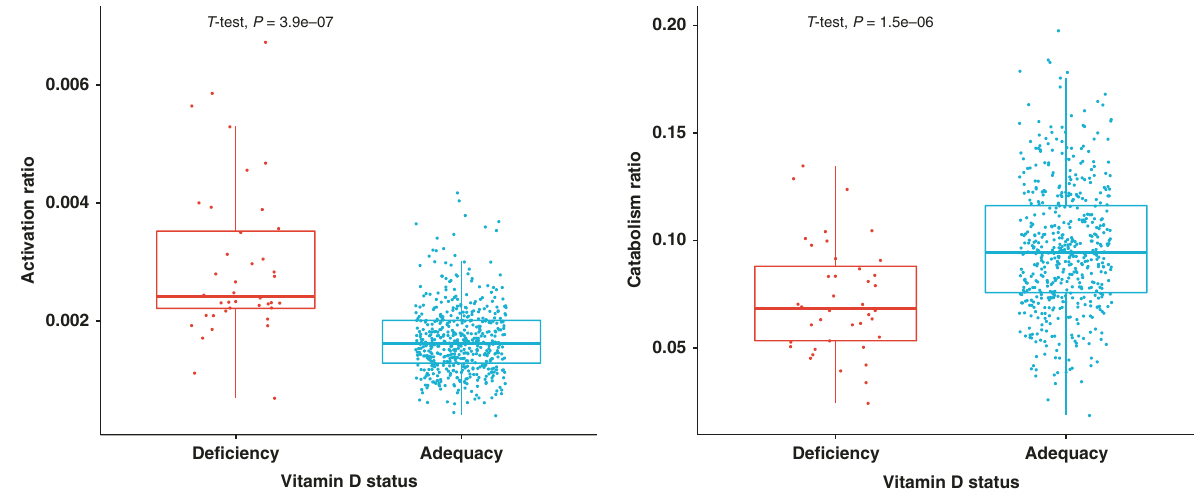
Fig. 6 Vitamin D metabolic ratios vary with differences in 25(OH)D status. Vitamin D de fi ciency correlates with signi fi cantly higher vitamin D activation ratio ( a ), while the catabolism ratio is increased in vitamin D adequacy ( b ) (box plots indicate median (middle line), 25th, 75th percentile (box) and each single dot represents a sample, with sample size n = 40 for subjects with vitamin D de fi ciency and n = 515 for subjects with vitamin D adequacy; p -values obtained from two-sided t -test). Source data are provided as Source data fi le: “ sourcedata_ fi g6.txt ”